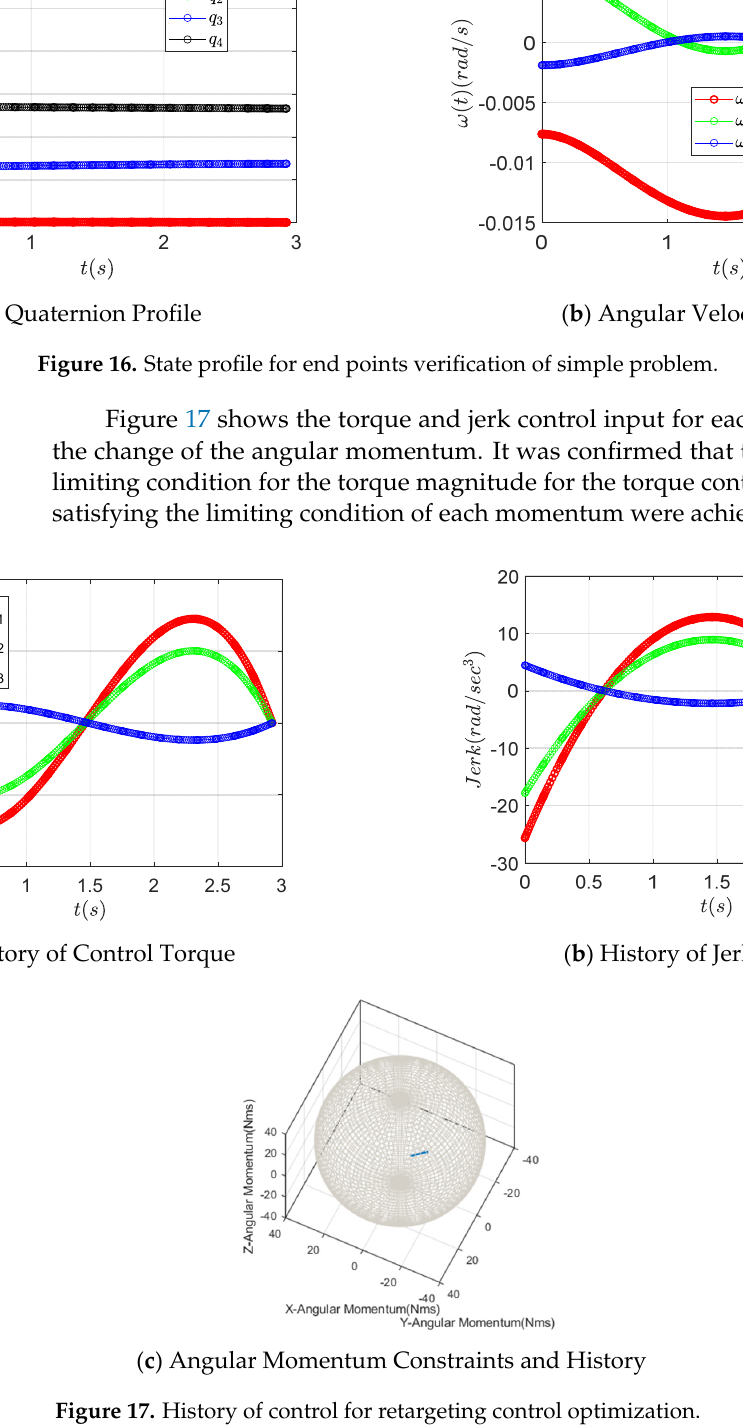
mesh each time the mesh was redefined according to the concept shown in Figure 15.